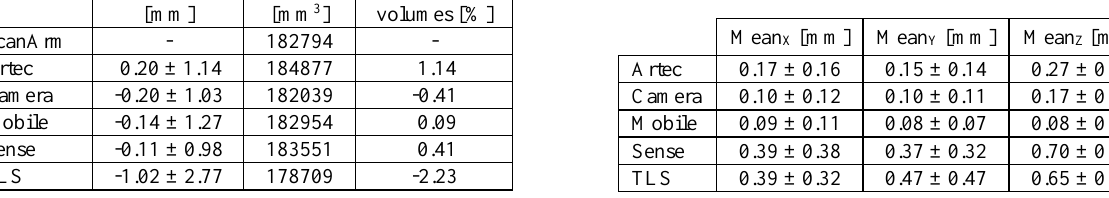
Table 4. Deviation values of the models compared to the Table 5. Statistics of differences deriving from cross-sections